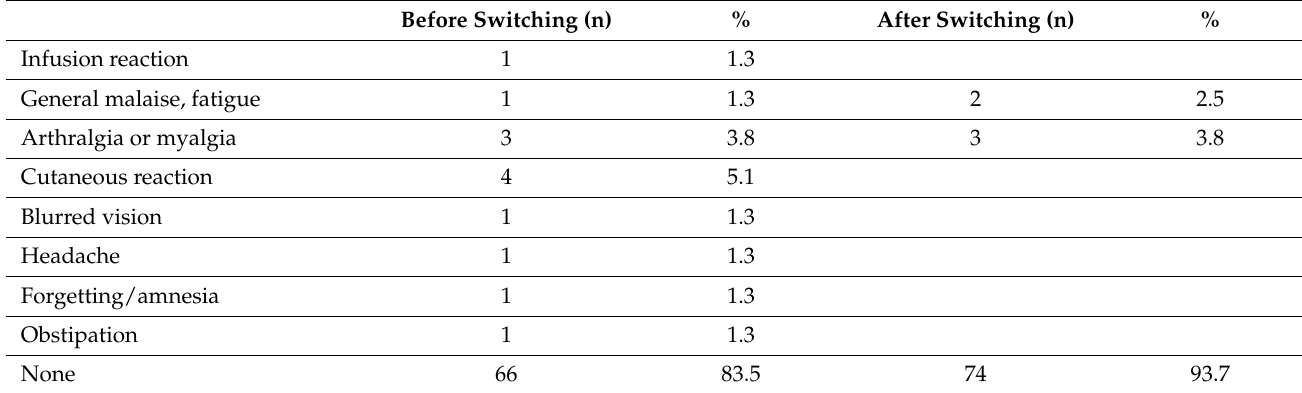
Table 2. Overview of adverse events related to infliximab therapy before switching (Remicade ® or Inflectra ® ) and after switching (Flixabi ®